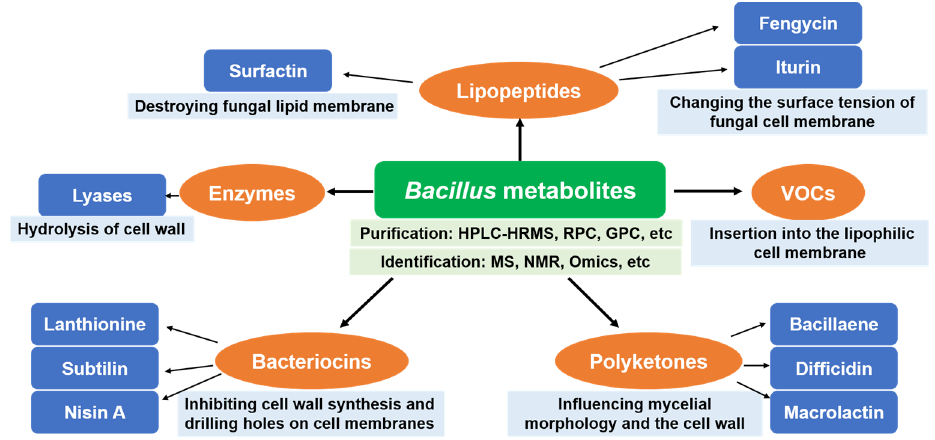
Figure 4. Classification, purification and identification technologies and antifungal mechanisms of Bacillus metabolites.